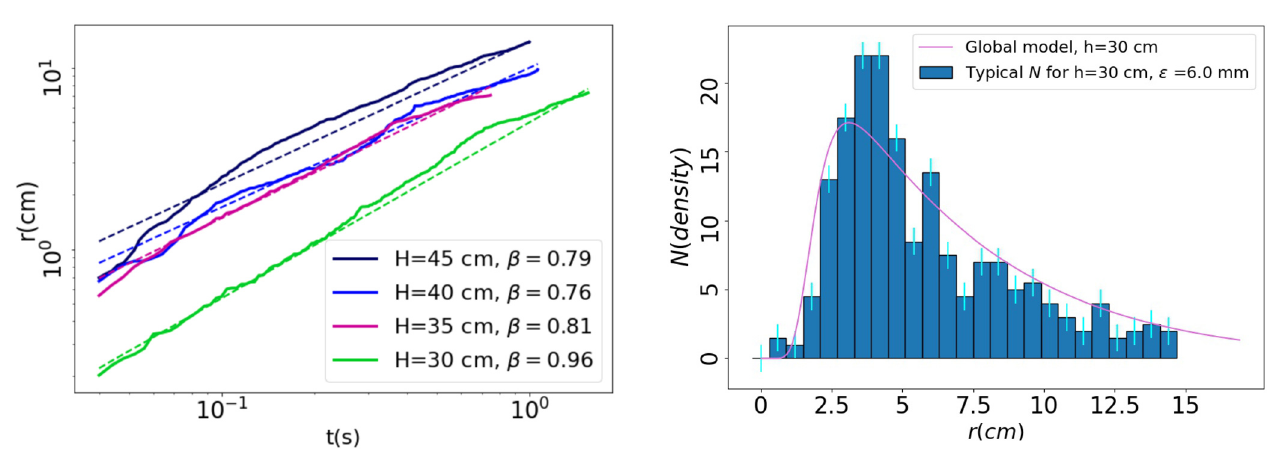
Fig. 6. Different tracking of bubbles in function of time, H is the height through which the jet falls, β is the linear coefficient, r 2 = 0 . 97 .